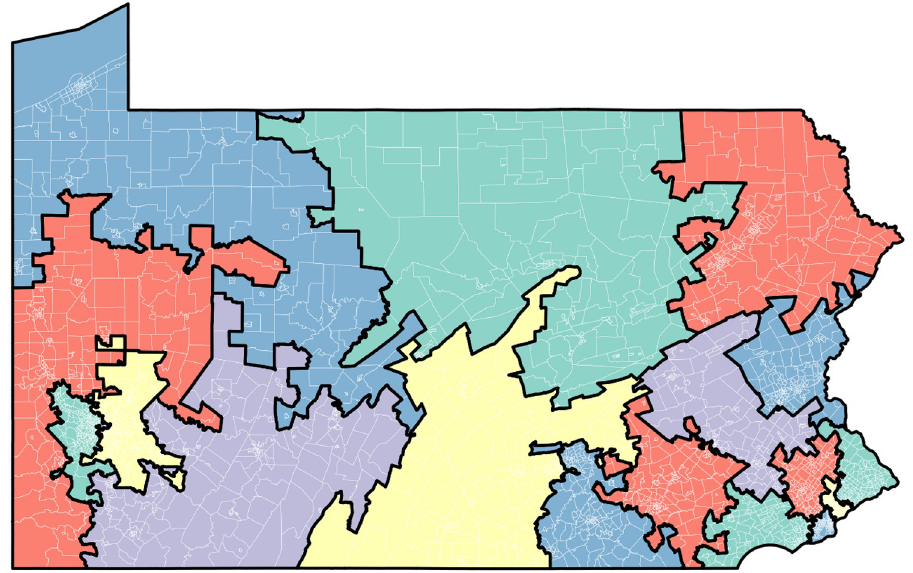
Fig 4. PA plan with one Black majority district and a second district with more than 40% Black residents. The small blue-gray district in the southeast of Pennsylvania, on the border, with a yellow district to its northeast, is 50.4% Black. It is split between Philadelphia County and Delaware County. The yellow district adjacent is 40.5% Black. It is split between Philadelphia County and Montgomery County. The plan is contained in file df2019-10- 25x21x16x16x753018pc0.01x615.csv, which is part of the repository of 11,206 plans